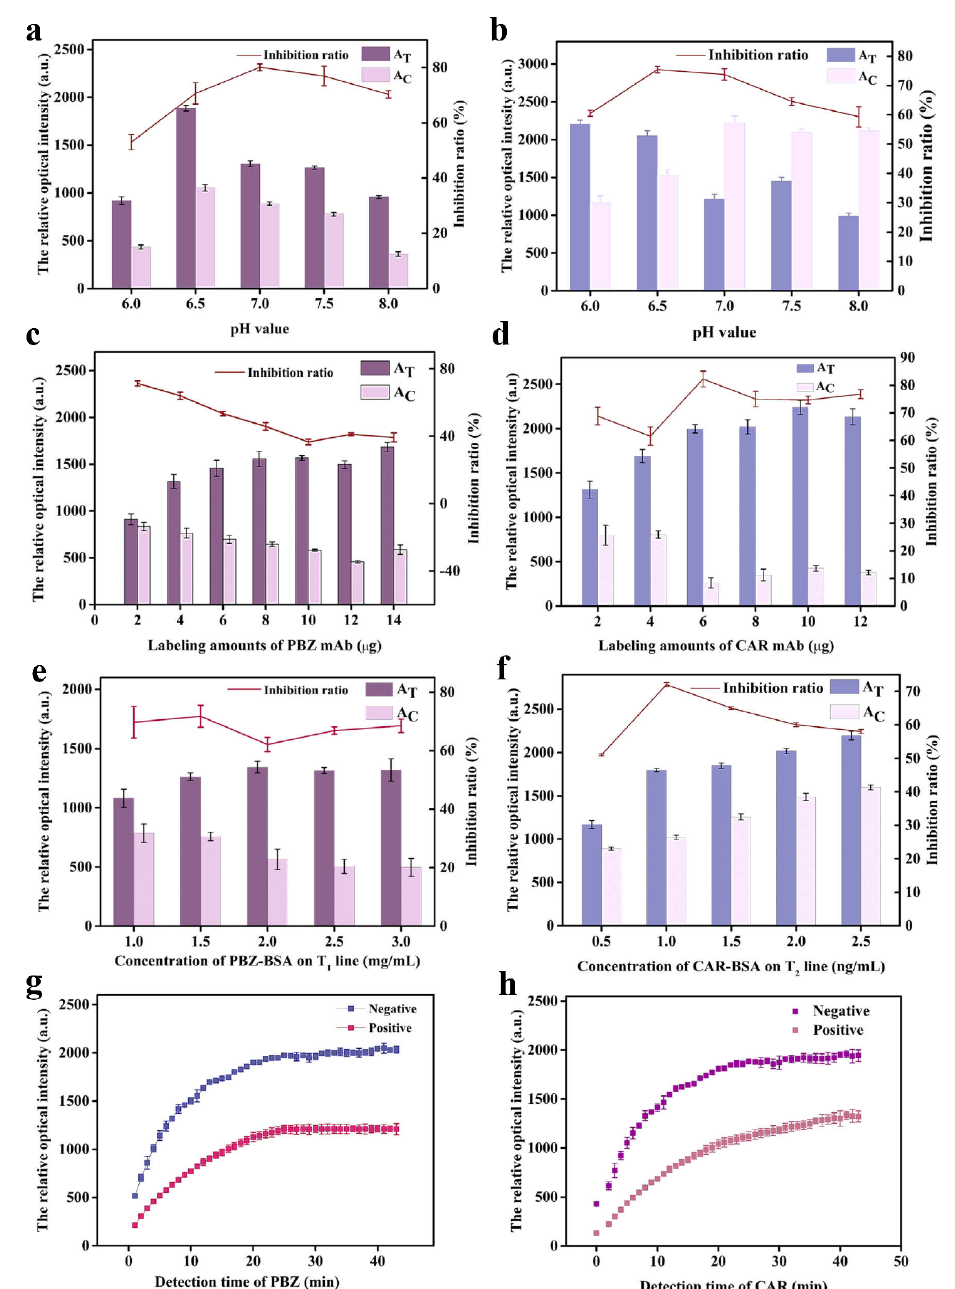
Figure 3. Optimization of key parameters of ICA. ( a ) pH values of AuNC@PDA coupled with PBZ mAb and ( b ) AuNPs coupled with CAR mAb. ( c ) The amounts of PBZ-mAb coupled with AuNC@PDA and ( d ) CAR mAb coupled with AuNPs. ( e ) Concentration of PBZ – BSA on T 1 line. ( f ) Concentration of CAR – BSA on T 2 line. Detection times of ( g ) PBZ and ( h ) CAR. The standard devi- ation was calculated from the results of three independent tests. The inhibition ratio was defined as (1 − B/B 0 ) × 100%, where B 0 and B represent the T line optical intensity of the negative sample and the PBZ/CAR-spiked sample (10 ng mL − 1 ), respectively. Each experiment was conducted in tripli- cate.